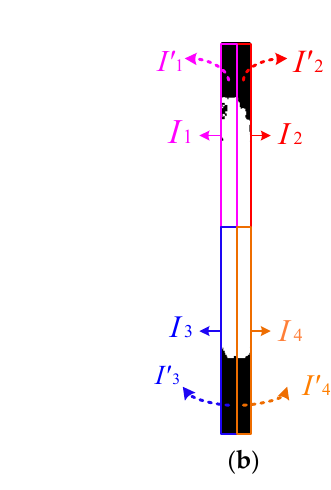
Figure 4. Schematic of ship surrounding correlation context sub-model blocks. ( a ) Candidate region captured from Section 2.3; ( b ) Blocks and water area of the candidate region.